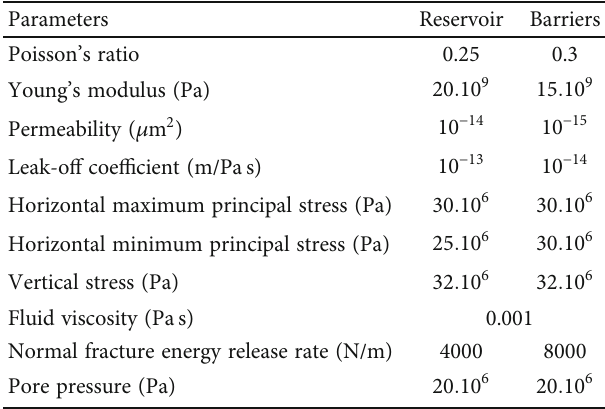
Figure 8: Modeling of hydraulic fracturing. Table 2: Basic parameters of numerical simulation